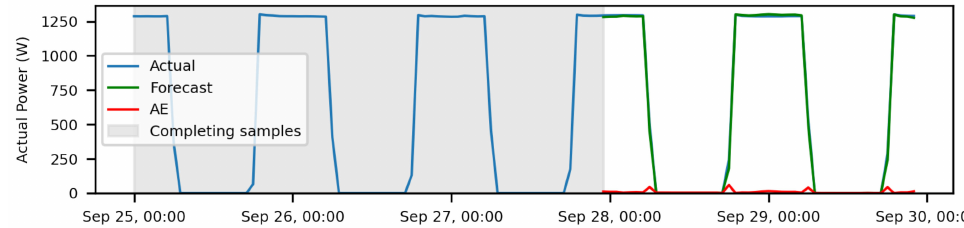
Figure 11. Simulation result for a set of ZP 1 measurements (measurements without failure).